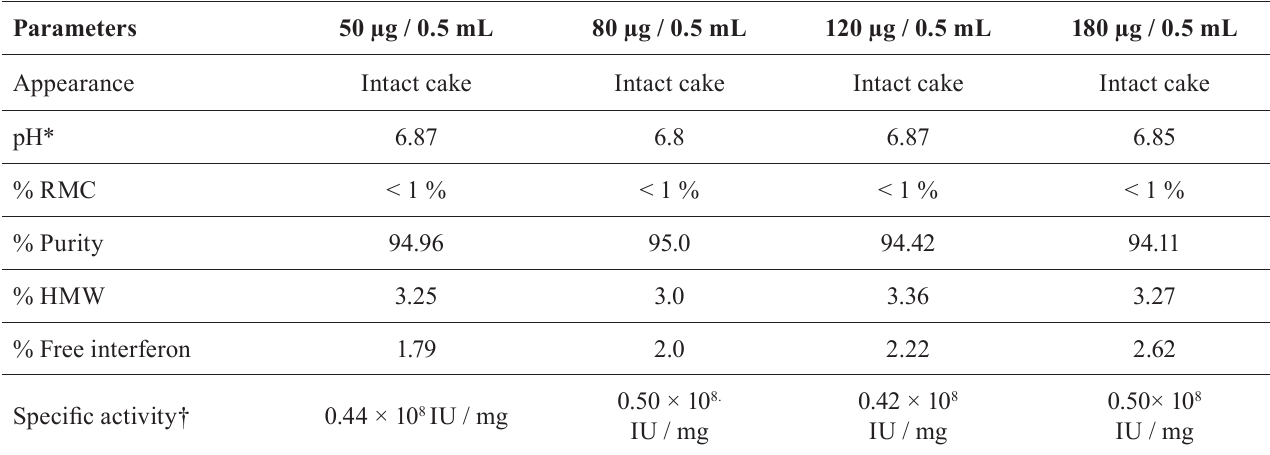
% Free interferon 1.79 Specific